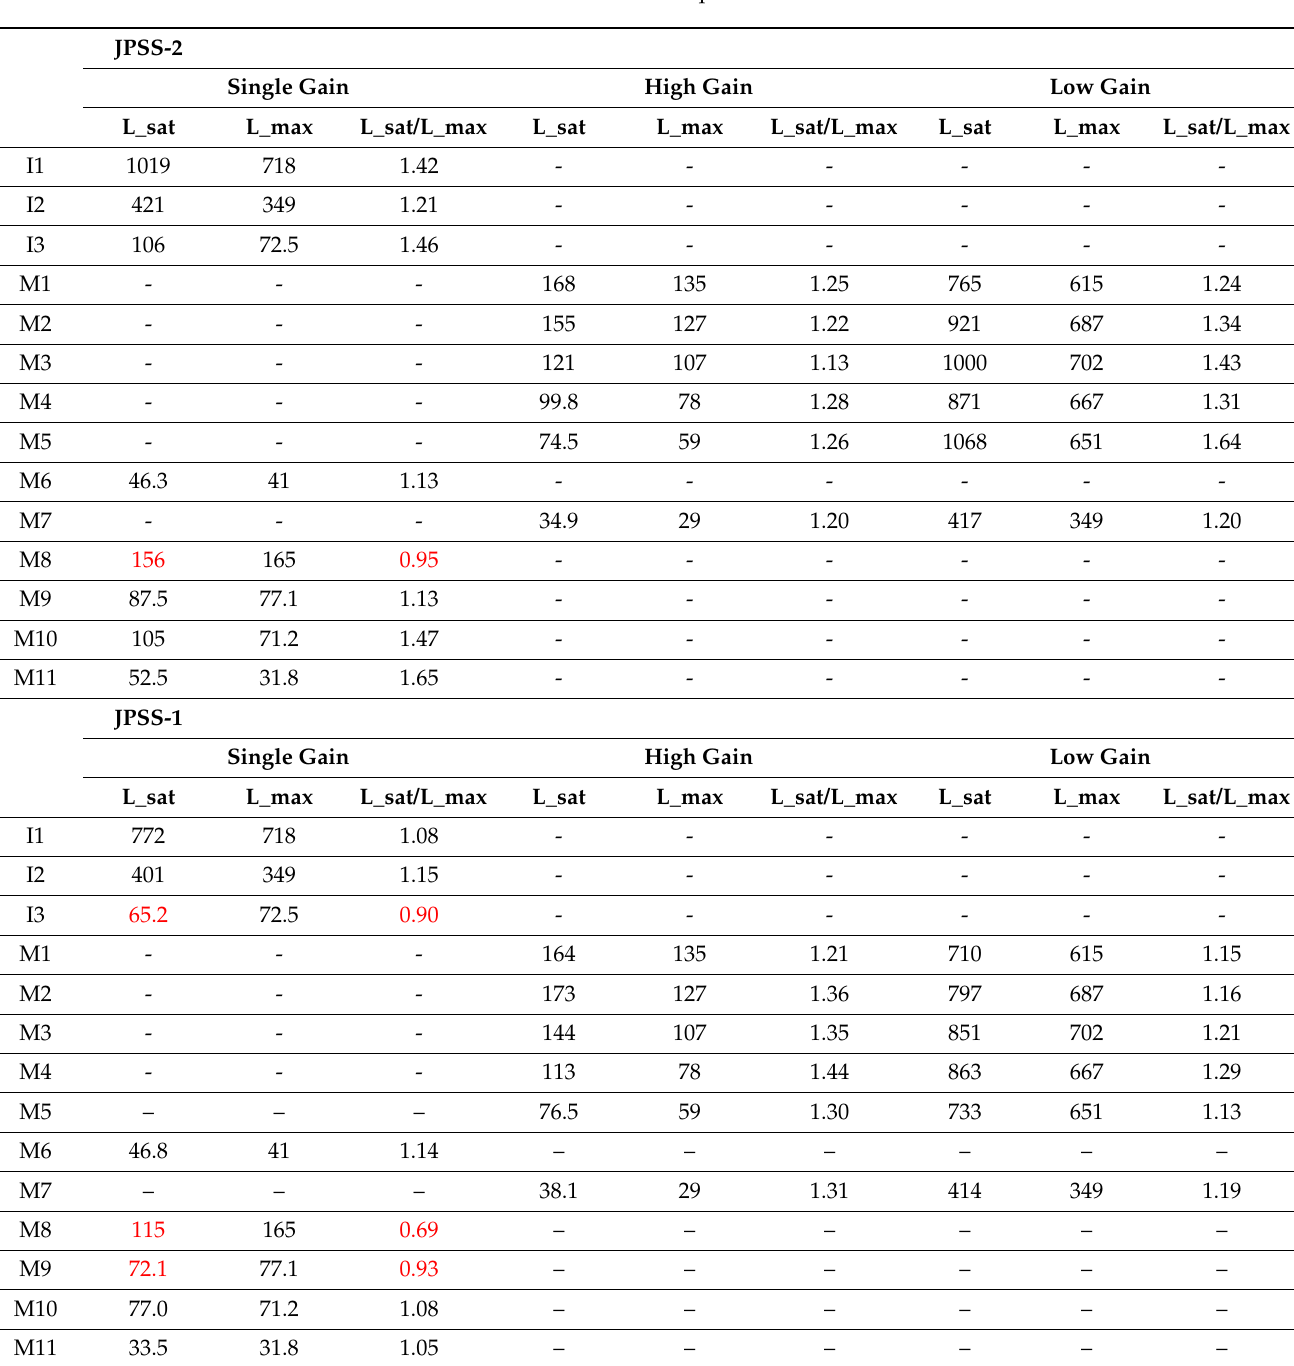
Table 2. Measured dynamic range performance for the reflective solar bands. The top portion is for JPSS-2 and band M8 fails the instrument specification. The bottom portion is for JPSS-1 where several bands failed to meet the instrument